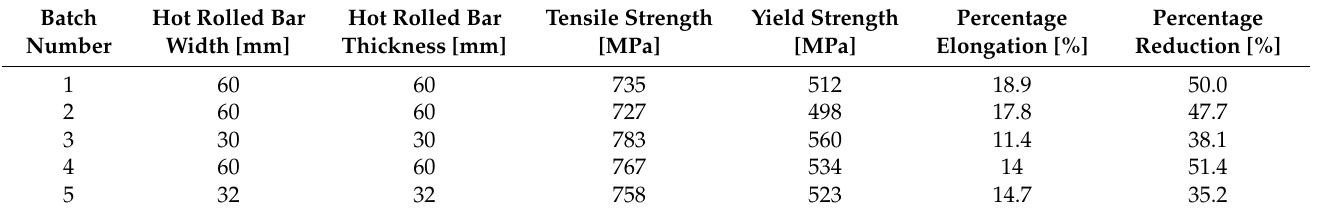
Table 4. The geometry and mechanical properties for five successively cast batches of 30MnVS6 with statistically significant reduction of content of